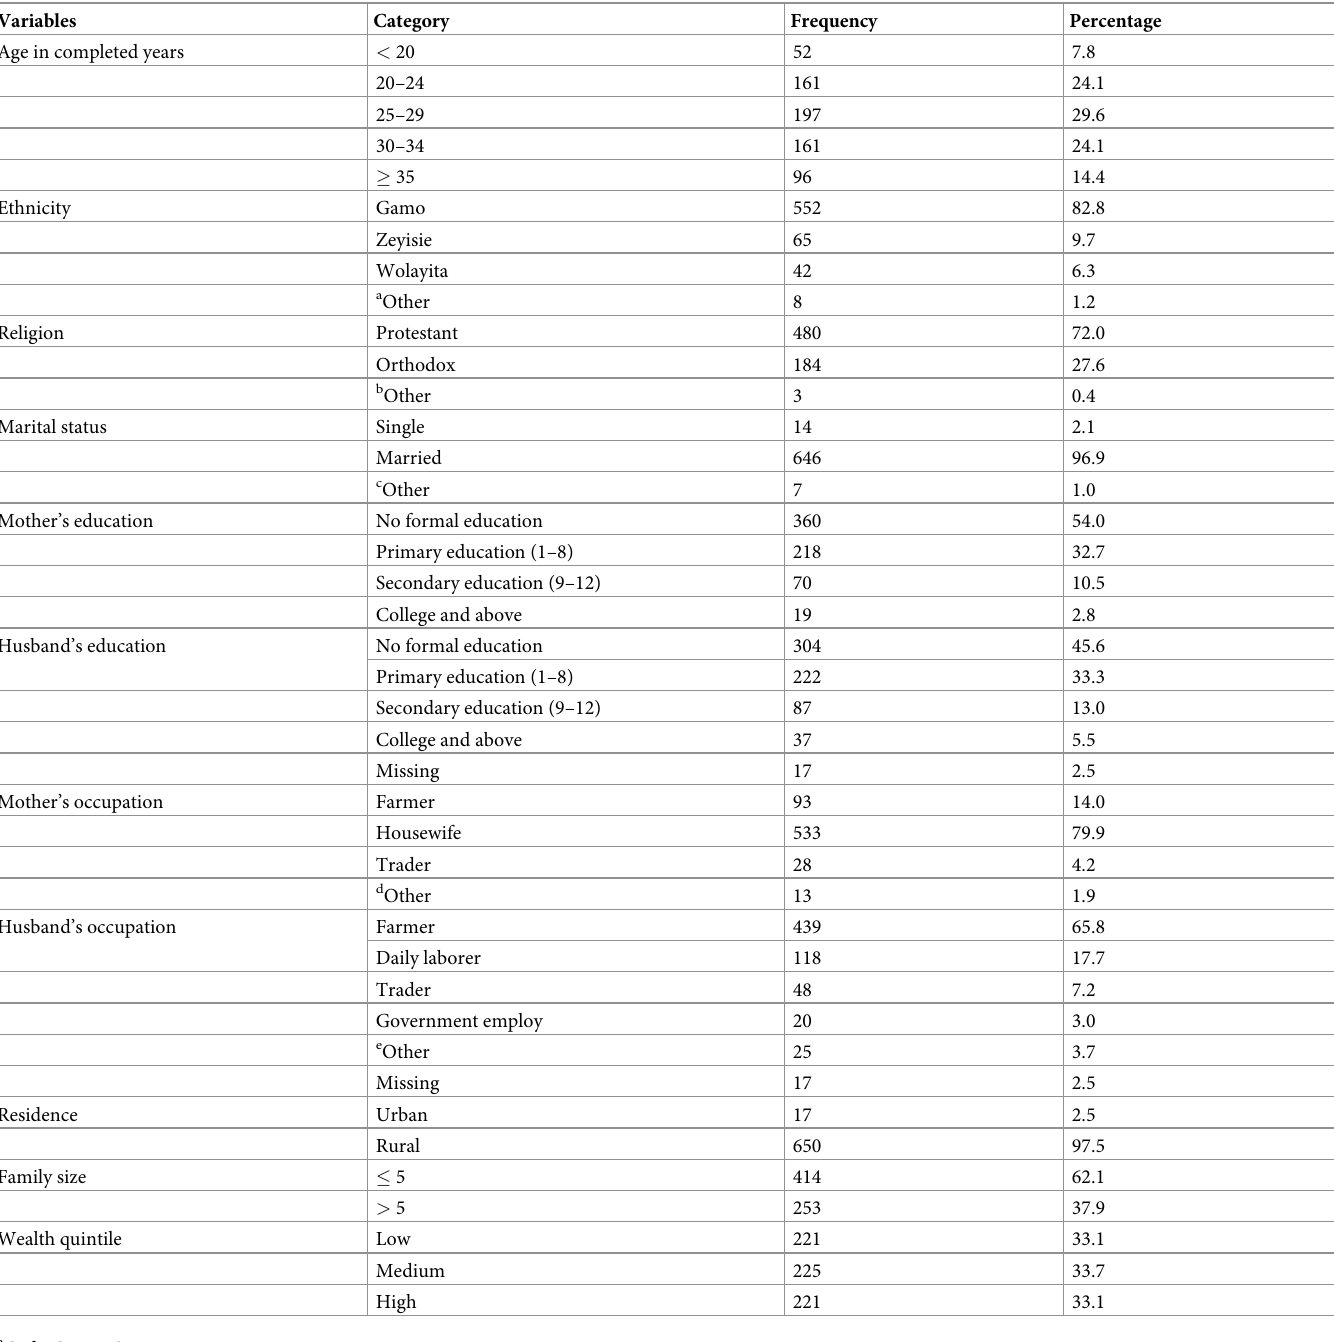
Table 1. Socio-demographic characteristics of participants in Arba Minch Zuria district, Gamo zone, southern Ethiopia 2019, (n =